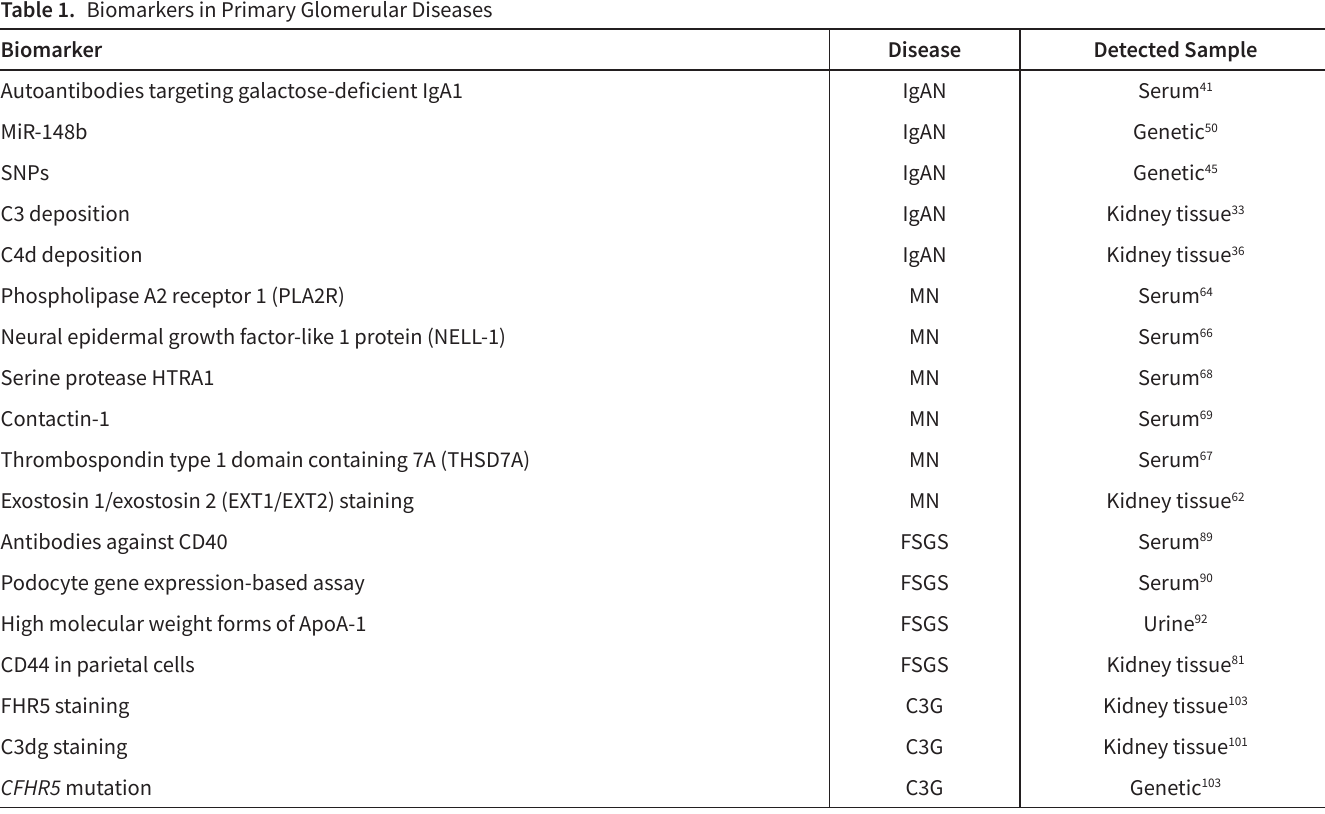
Table 1. Biomarkers in Primary Glomerular Diseases